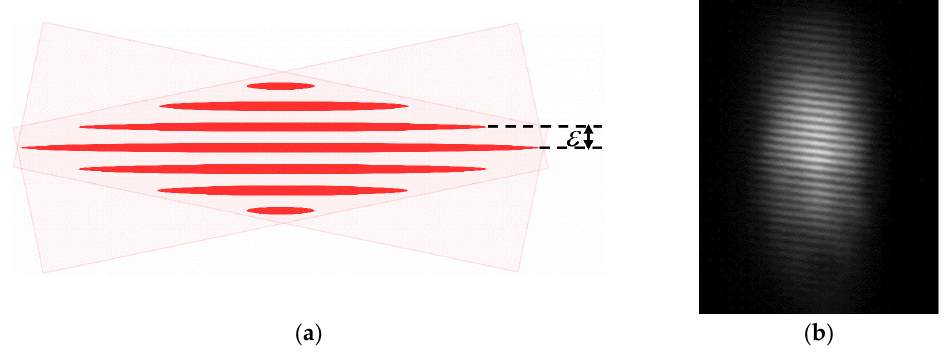
Figure 3. The fringe pattern. ( a ) Schematic of fringes; ( b ) The fringe pattern taken by a CMOS cam- era.